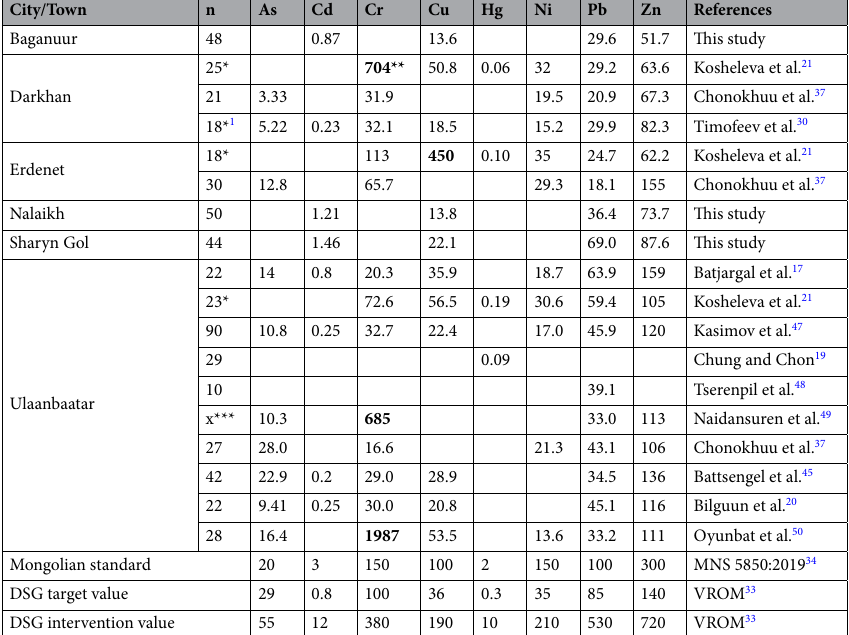
Table 3. Summary of studies on contamination of Mongolian urban soils with metal(loid)s (average values in mg/kg). n number of samples, DSG Dutch Soil Guidelines; studies exceeding all the standards are bold. *Data selected from the study’s category with the most samples. **Possible incorrect value inconsistent with the text of the article. ***XRF readings on 340